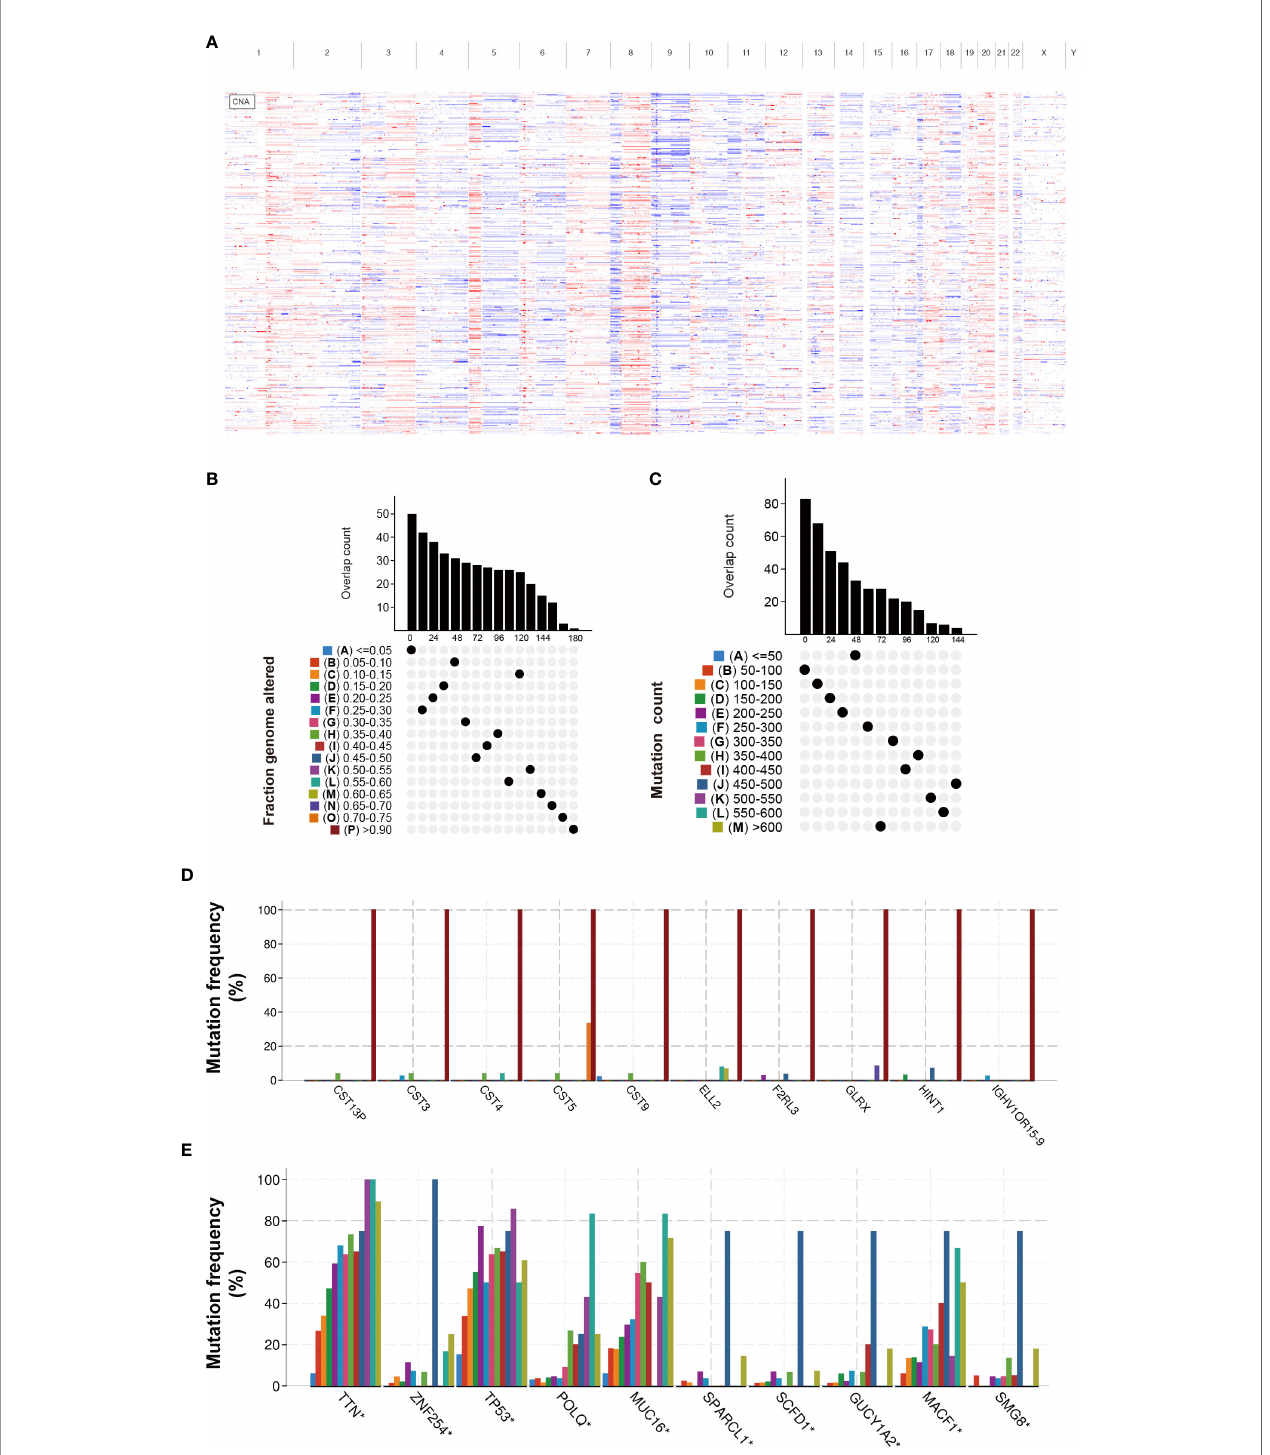
FIGURE 1 | Identi fi cation of candidate neoantigens in BLCA. (A) Chromosomal distribution of ampli fi ed and deleted copy number genes in BLCA. (B) Overlapping mutated genes distributed in the distinct genome alteration group. (C) Overlapping mutated genes distributed in the distinct mutation count group. (D) The genes with the highest frequency in the genome alteration group. (E) The genes with the highest frequency in the mutation count group. *P<